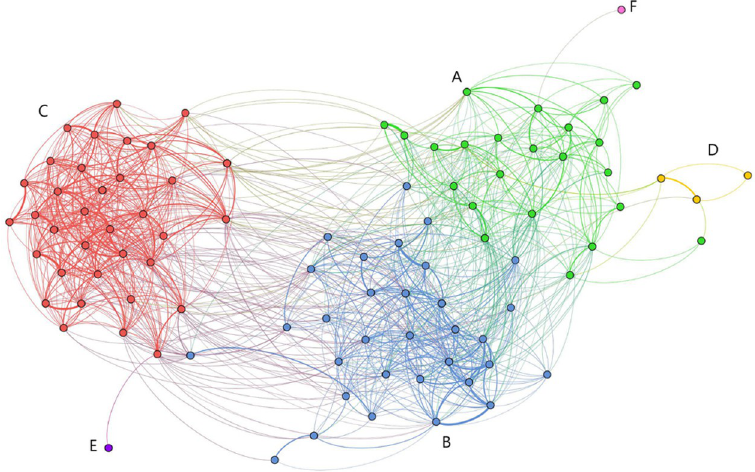
Fig 5. Sociogram from the social network analysis of estuarine-resident dolphins in North Carolina. Sociogram from the social network analysis of estuarine-resident common bottlenose dolphins ( Tursiops truncatus ) in North Carolina. The analysis includes all dolphins with � 7 sightings, resulting in a sample size of 95 individuals and 942 sightings. Six clusters were identified, one of which comprised three individuals (Cluster D, yellow), and two of which comprised a single individual (Clusters E, purple, and F, pink).